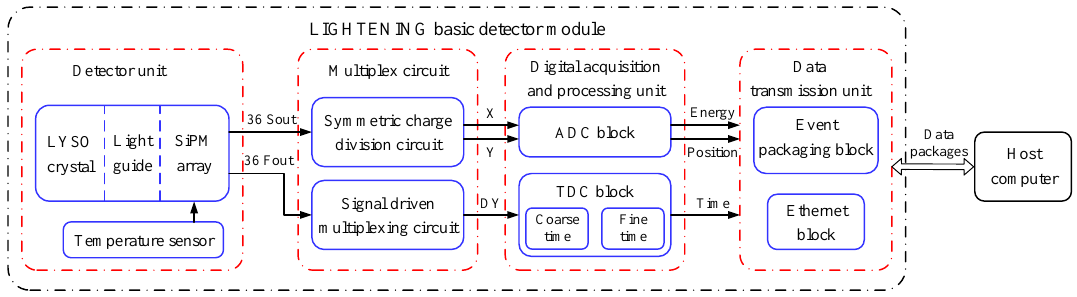
Figure 1. The scheme of instrumentation setup of the LIGHTENING (cid:114) PET basic detector